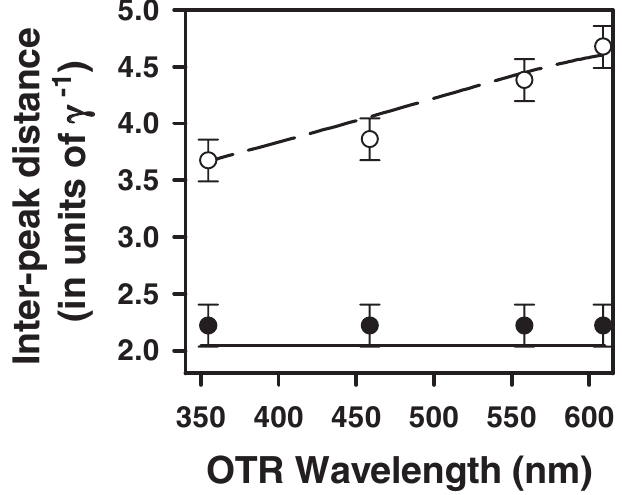
FIG. 19. Interpeak distance as a function of the radiation wavelength measured with (black circles) and without (open circles) the lens ( f (cid:5) 0 : 2 m ). Lines represent the theoretical prediction.